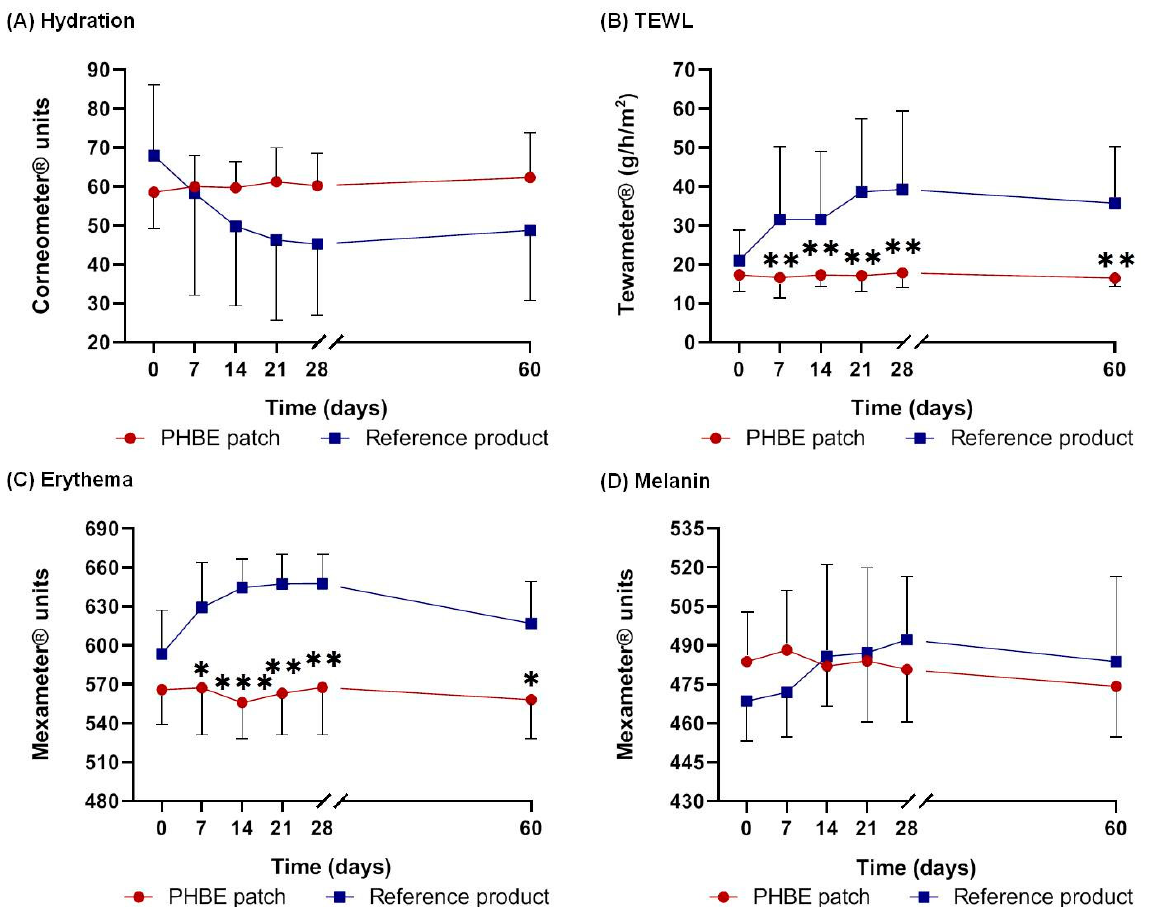
Figure 8. Evaluation of ( A ) hydration, ( B ) TEWL, ( C ) erythema, and ( D ) melanin, before radiation therapy (RT) (Day 0); during Days 7, 14, 21, and 28; and 1 month after RT (Day 60). Regarding TEWL and erythema, significant differences were recorded between the two interventions at most of the time points (* p < 0.05, ** p < 0.01, *** p < 0.001). All the biophysical skin parameters returned to the initial values 1 month after RT (Day 60) for the patients using the PHBE patch.